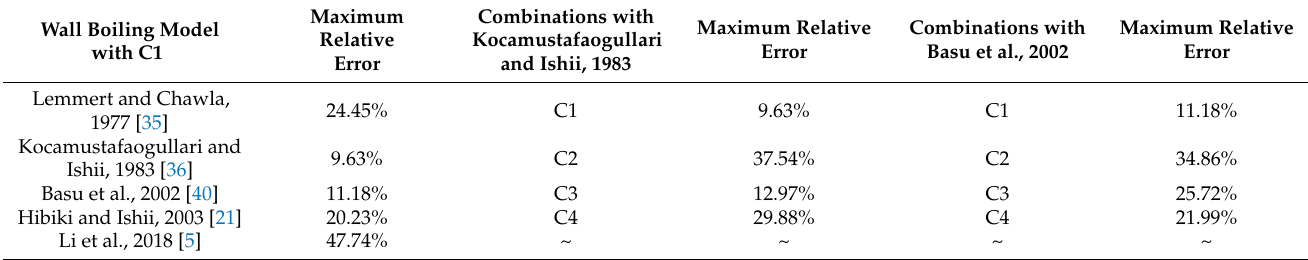
Table 8. Maximum relative errors between numerical results of d p with DEBORA-1 experiment data ( P = 2.62 MPa) for first loop of NPP ( P = 15.70